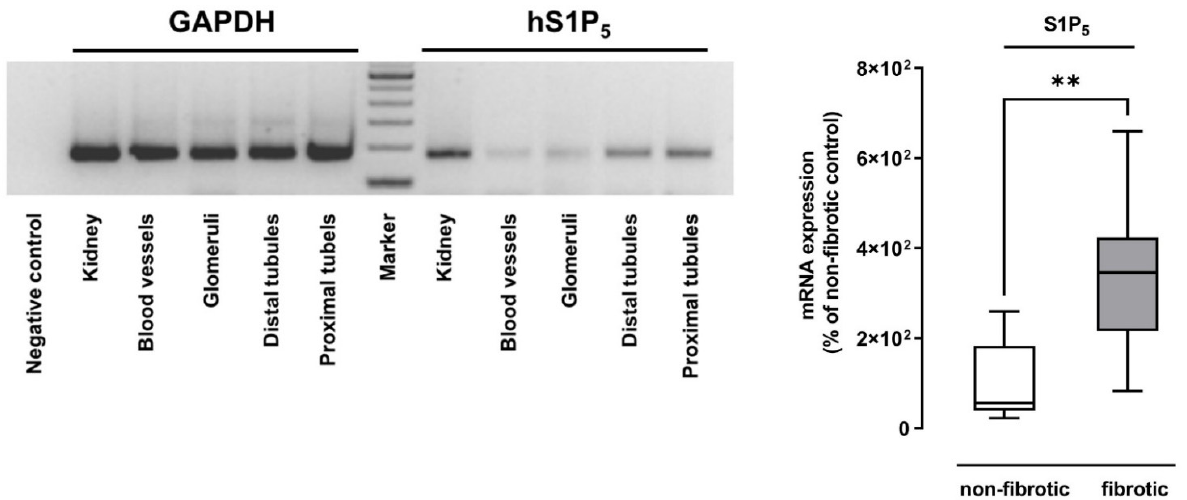
Figure 1. Expression of S1P 5 in human kidney samples. PCR of S1P 5 mRNA expression in human kidney and kidney tissue sections (left side) and quantification from RT-PCR of S1P 5 mRNA in non-fibrotic and fibrotic kidney tissue of patients suffering from hydronephrosis (right side). GAPDH was used as a control in both experiments. Data are shown as box plots with a line at the median and whiskers from minimum to maximum value; n = 5 (non-fibrotic), n = 10 (fibrotic), ** p < 0.01; Mann–Whitney U test.